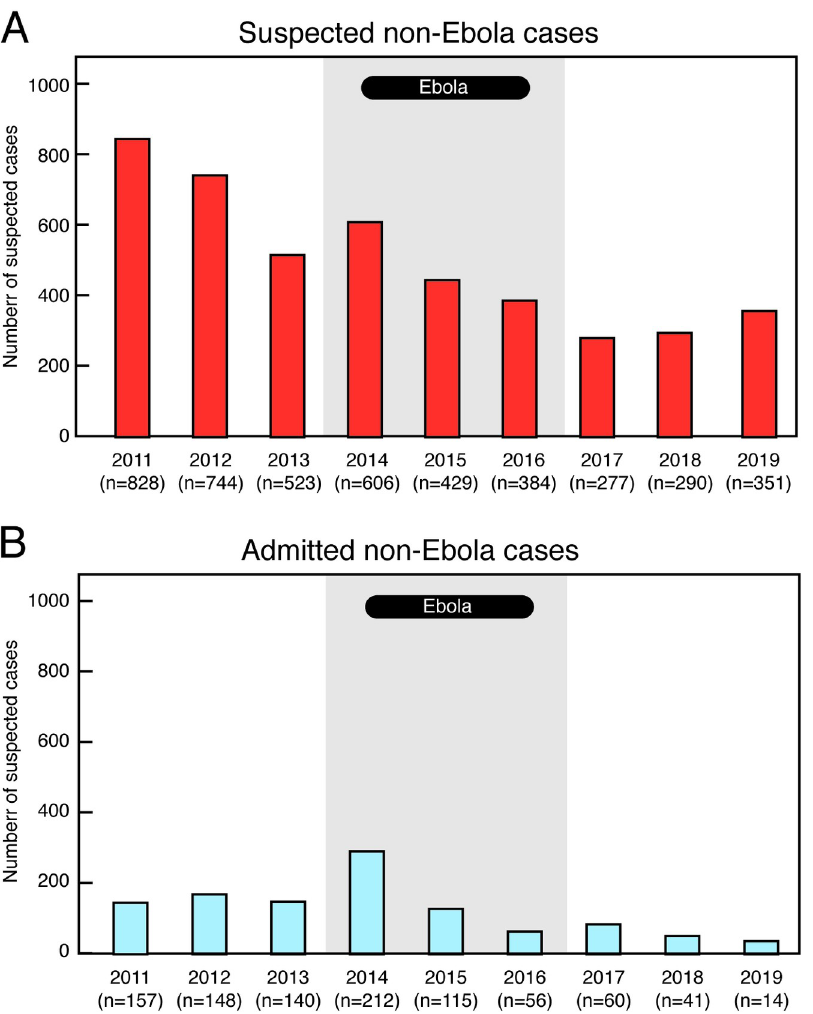
Fig 1. Annual numbers of subjects presenting and admitted to the Kenema Government hospital Lassa ward with suspected Lassa fever. Panel A. Subjects presenting with suspected Lassa fever from 2011–19. Panel B; Patients admitted to the Lassa Ward from 2011–19. Grey shading indicates the years 2014–16 during the West African Ebola